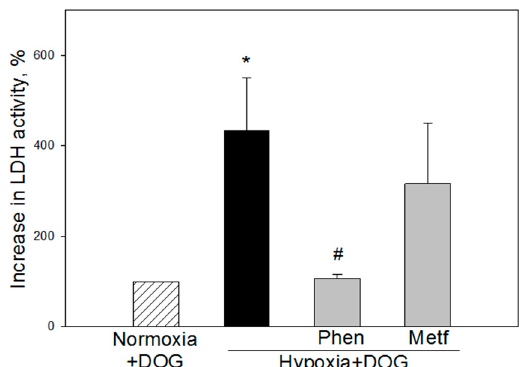
Figure 3. Effect of phenformin and metformin on simulated ischemia-induced cell death in brain slice cultures from 5–7 days old rats. Where indicated, 0.025 mM phenformin (Phen) or 0.5 mM metformin (Metf) was added to slice culture incubation medium before the start of simulated ischemia as described in Methods. The level of necrosis after simulated ischemia, indicated as treatment with 10 mM DOG and 24 h hypoxia, was evaluated by measuring increase in LDH activity in slice culture medium. The data were normalized against normoxic controls of each group assuming that normoxic level is 100% and presented as means ± standard errors of 8 separate experiments. *— p < 0.05 compared with normoxic control with DOG, #— p < 0.05 compared to hypoxia with DOG. In 2–3 month old rats brain slice cultures, preincubation with 0.025 mM phenformin and 0.5 mM metformin before hypoxia caused 2-fold decrease in LDH release (121 ± 16 and 126 ± 29%, respectively) compared with the hypoxia group (250 ± 12%) (Figure 4a). Under simulated ischemia conditions, metformin and phenformin had no effect on LDH release which was at the same level as at normoxia and hypoxia plus DOG (Figure 4b).